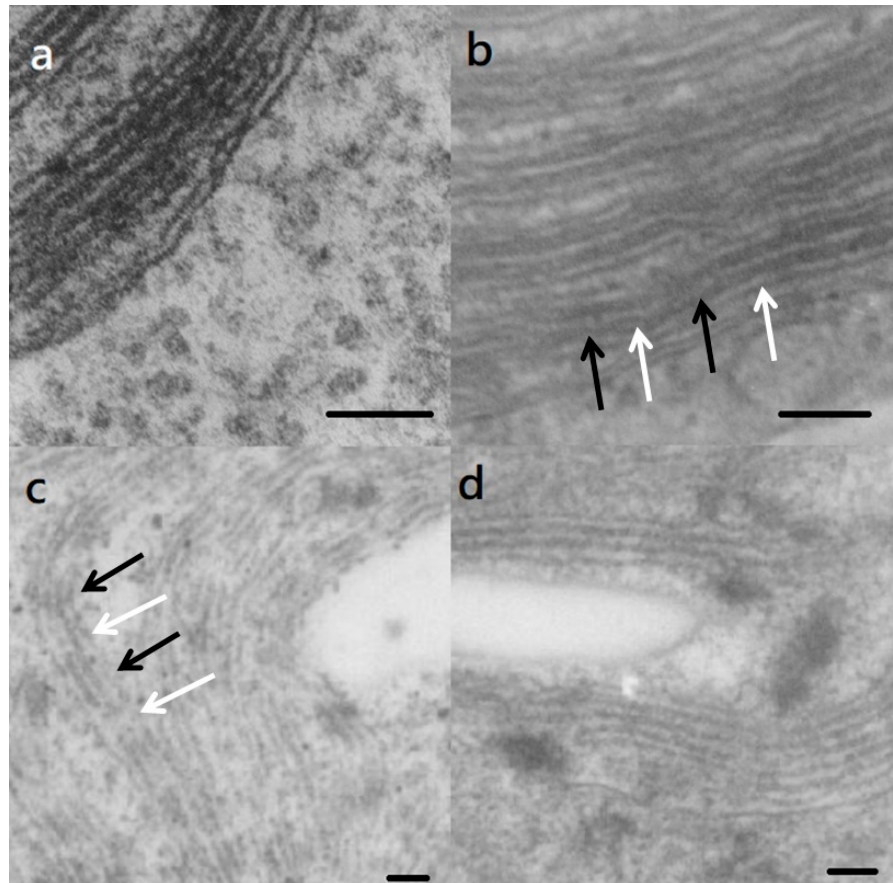
Figure 2. Transmission electron micrographs of the thylakoids of ( a ) freshly harvested S. vacuolatus (control) cell and the cells that had been heat-treated and then cultured under illumination for ( b ) 6 h, ( c ) 24 h, and ( d ) 72 h. Bars = 100 nm. The light and dark segments are indicated by white and black arrows, respectively.